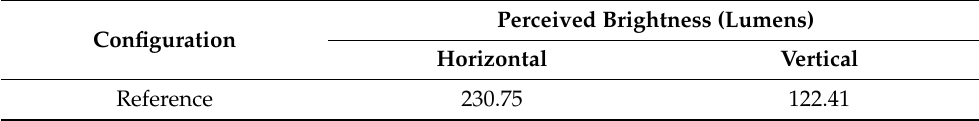
Table 1. Perceived brightness values for reference image.